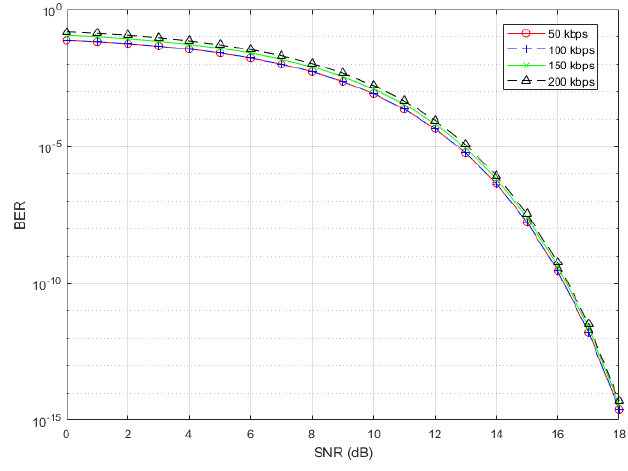
Figure 2. BER of the 2FSK Wi-SUN channel with various data rates (50, 100, 150, 200 kbps).